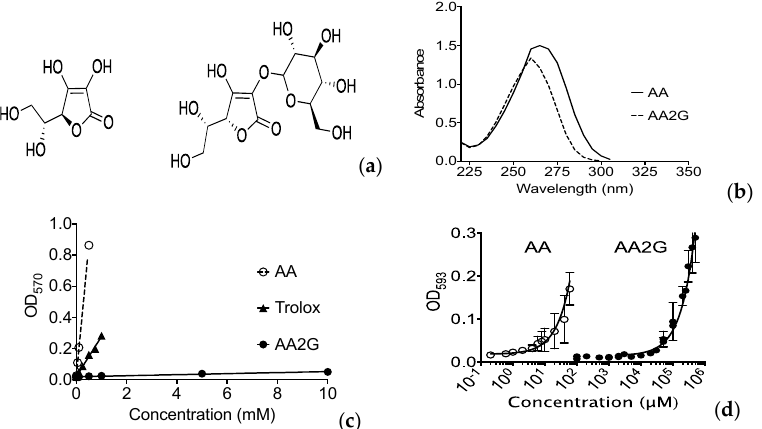
Figure 1. Chemical structures and basic characteristics of ascorbic acid and ascorbic acid 2-glucoside: ( a ) Chemical structures of ascorbic acid (AA) and ascorbic acid 2-glucoside (AA2G); ( b ) Absorption spectrum of 1 mM AA and AA2G solution; ( c ) In vitro total antioxidant capacity measured by reduction of Cu 2+ ;( d ) In vitro Ascorbic Acid specific antioxidant properties measured by reduction of Fe 3+ . Open circles indicate AA and closed circles indicate AA2G. Error bars indicate standard error of the means of three independent experiments.